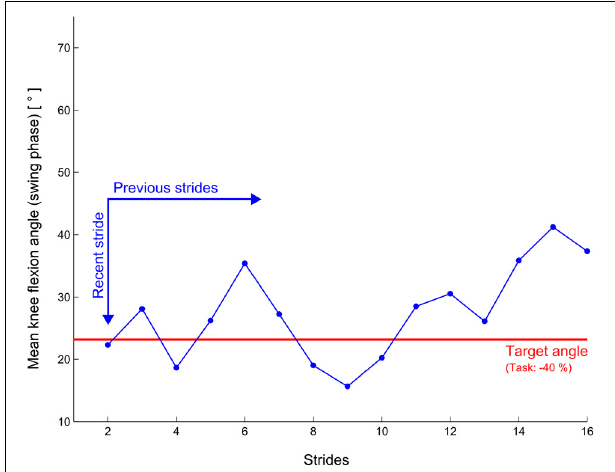
FIGURE 3 | Illustration of the feedback display of the pilot study with non-impaired subjects. The blue graph is shifted to the right on every